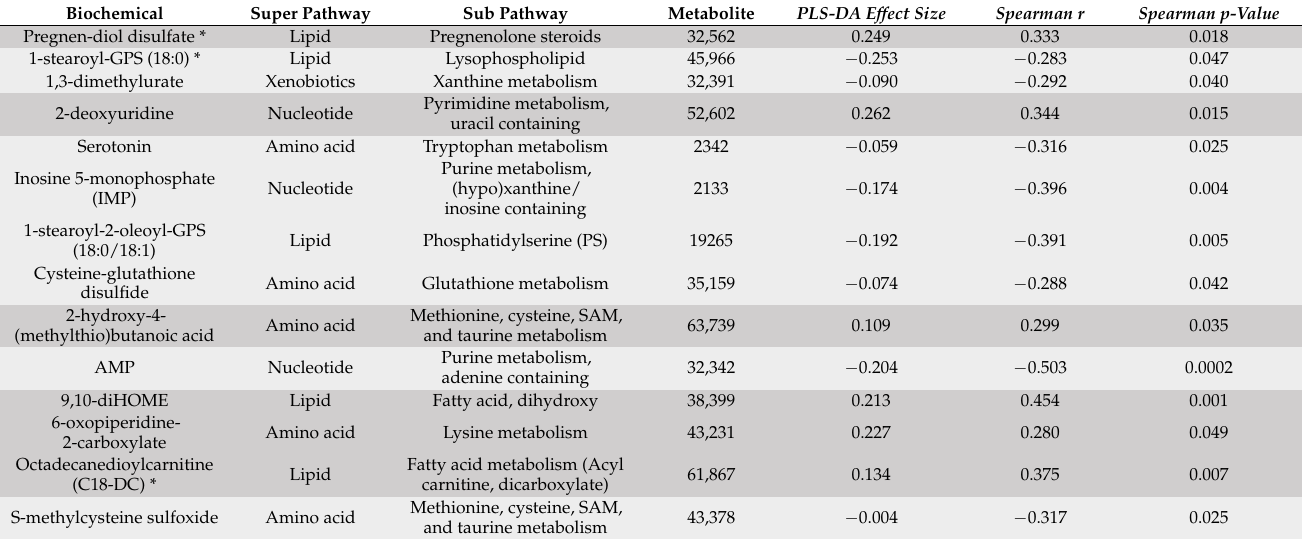
Table 3. Microbial metabolites that significantly differentiated participants with and without FIB-4 ≥ 1.45.